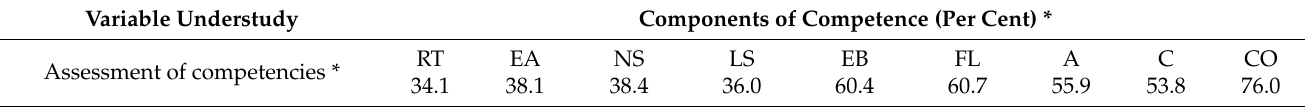
Table 6. Structure of competencies of Gen Z representatives. Variable